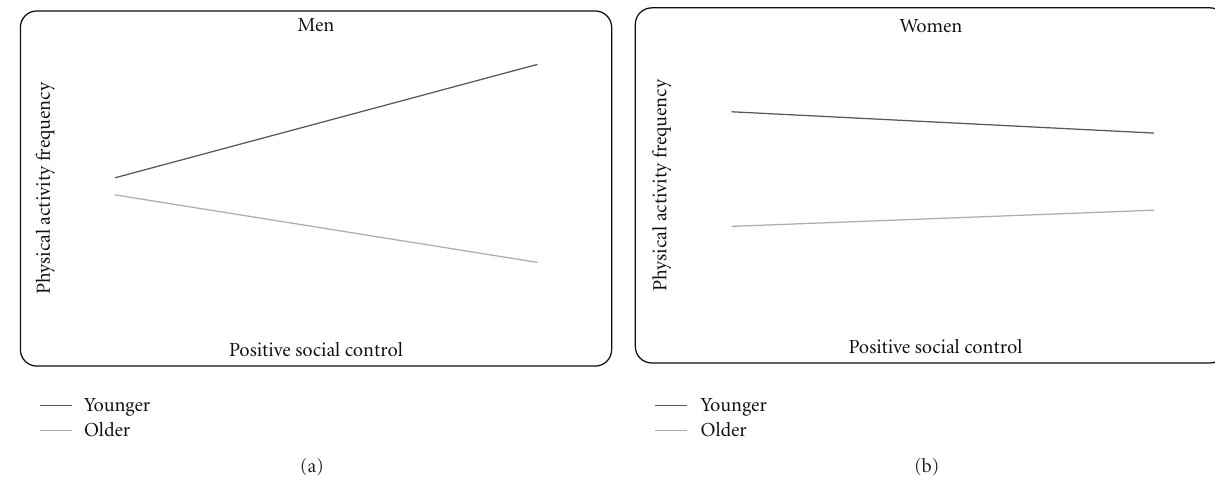
Figure 1: (a) The interaction of age and positive social control on physical activity for men. (b) The interaction of age and positive social control on physical activity for women. Note: the figures show predicted regression lines for one standard deviation above (high) and one standard deviation below (low) the mean of positive social control. The simple slope is statistically significant for older men.